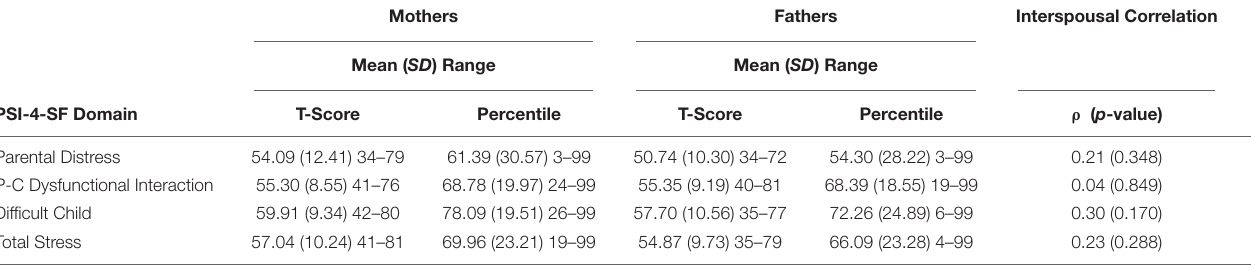
TABLE 4 | PSI-4-SF domain percentile scores ( n =